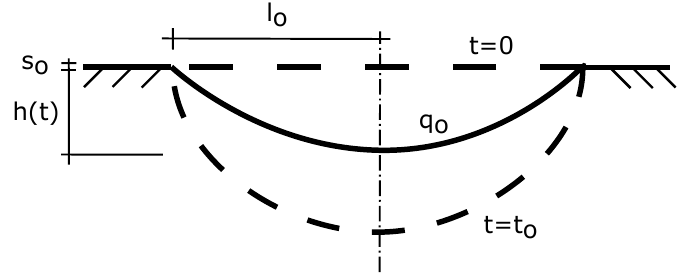
Figure 1. Geometrical scheme of a free-inflation